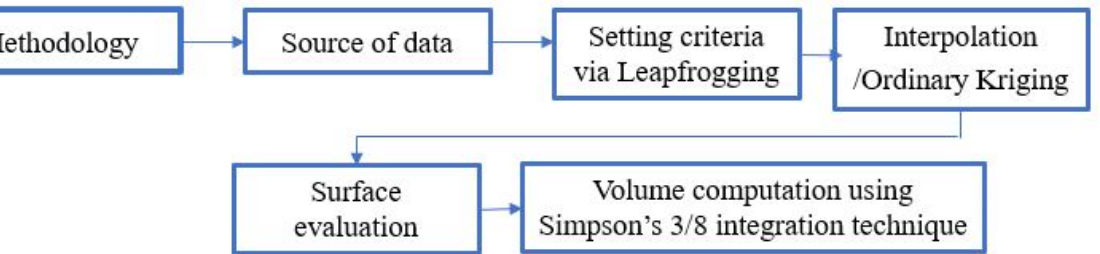
Figure 2. Methodology flow chart (Source: Research lab).